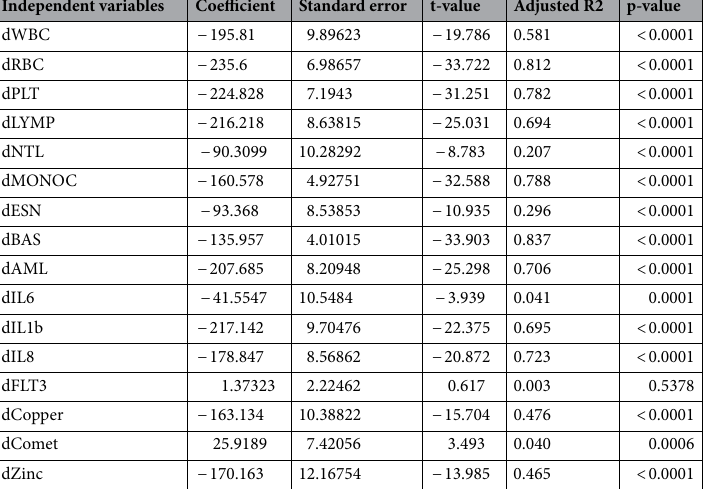
Table 2. Univariate linear regression analysis of relative change of the selected biomarkers for predicting the dose group.